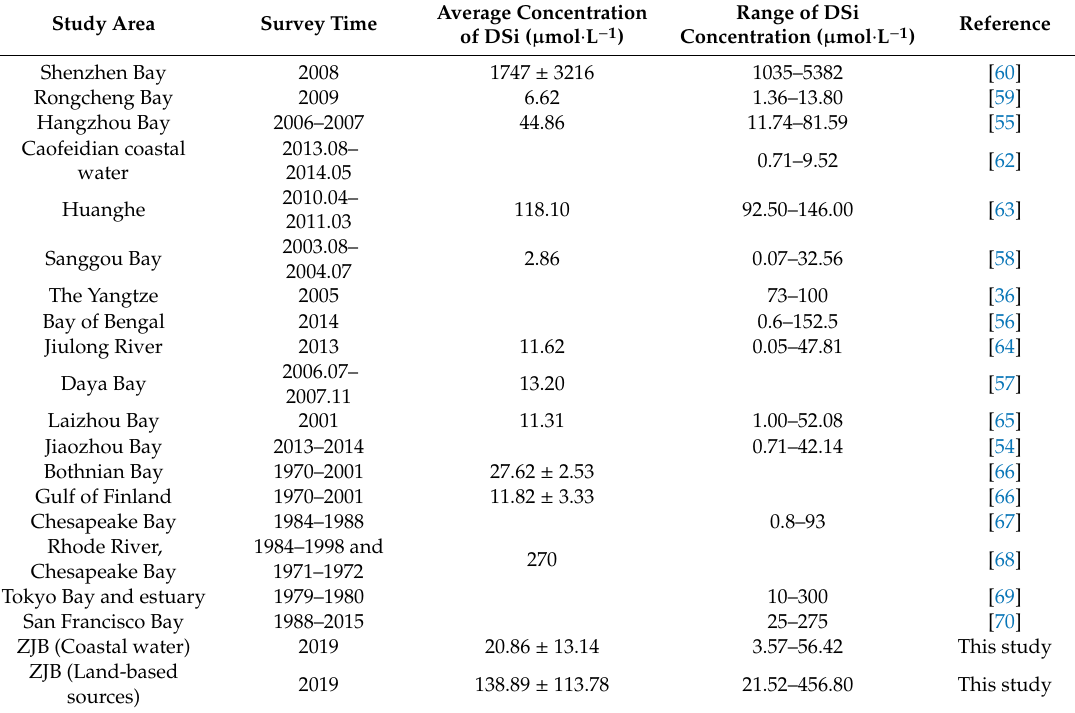
Table 2. Comparison of DSi concentration in Zhanjiang Bay (ZJB) with other bays and